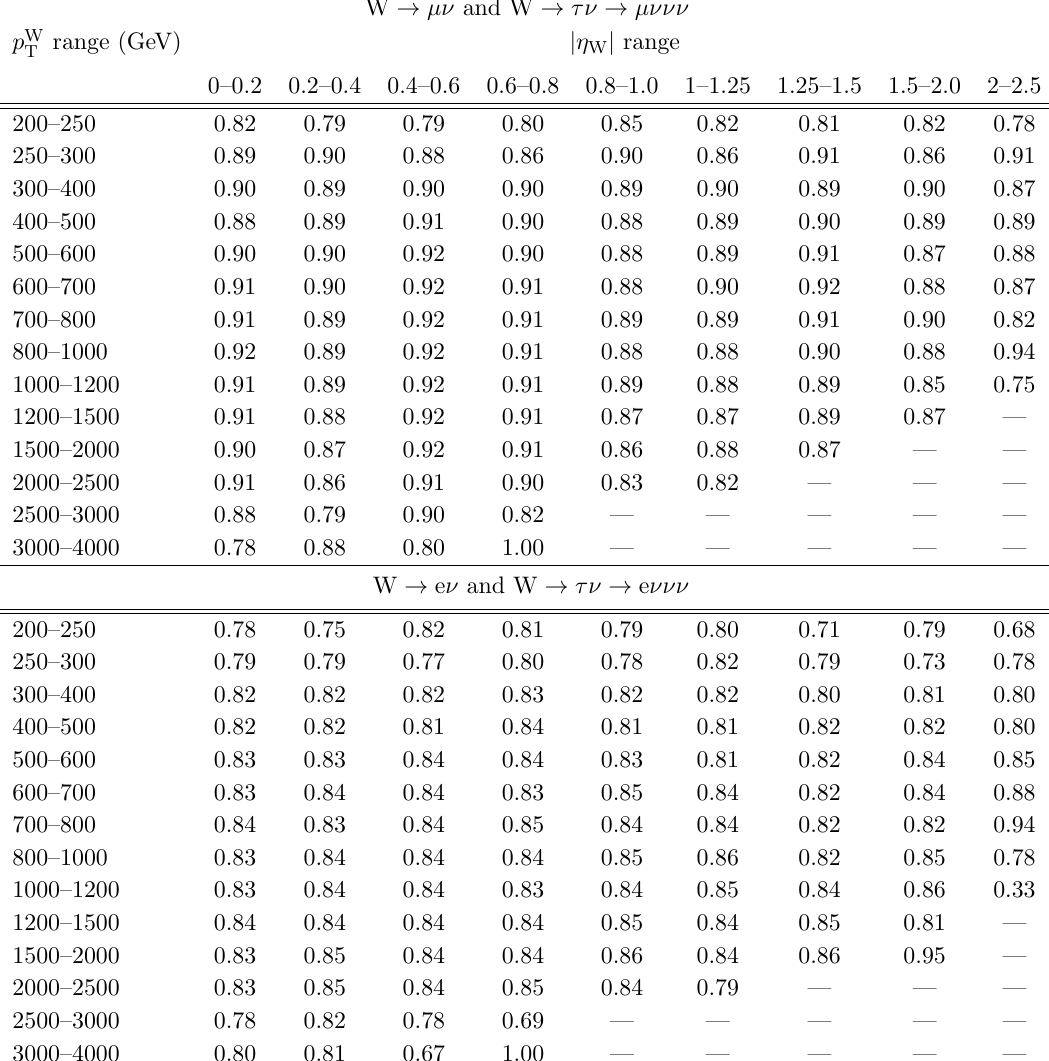
Table 11 . Reconstruction and identi(cid:12)cation e(cid:14)ciency for the (upper table) W ! (cid:22)(cid:23) and W ! (cid:28)(cid:23) ! (cid:22)(cid:23)(cid:23)(cid:23) , and (lower table) W ! e (cid:23) and W ! (cid:28)(cid:23) ! e (cid:23)(cid:23)(cid:23) decays as function of generated p W and j (cid:17) W j . Uncertainties in the e(cid:14)ciencies are included in the generic limit calculation as discussed in the